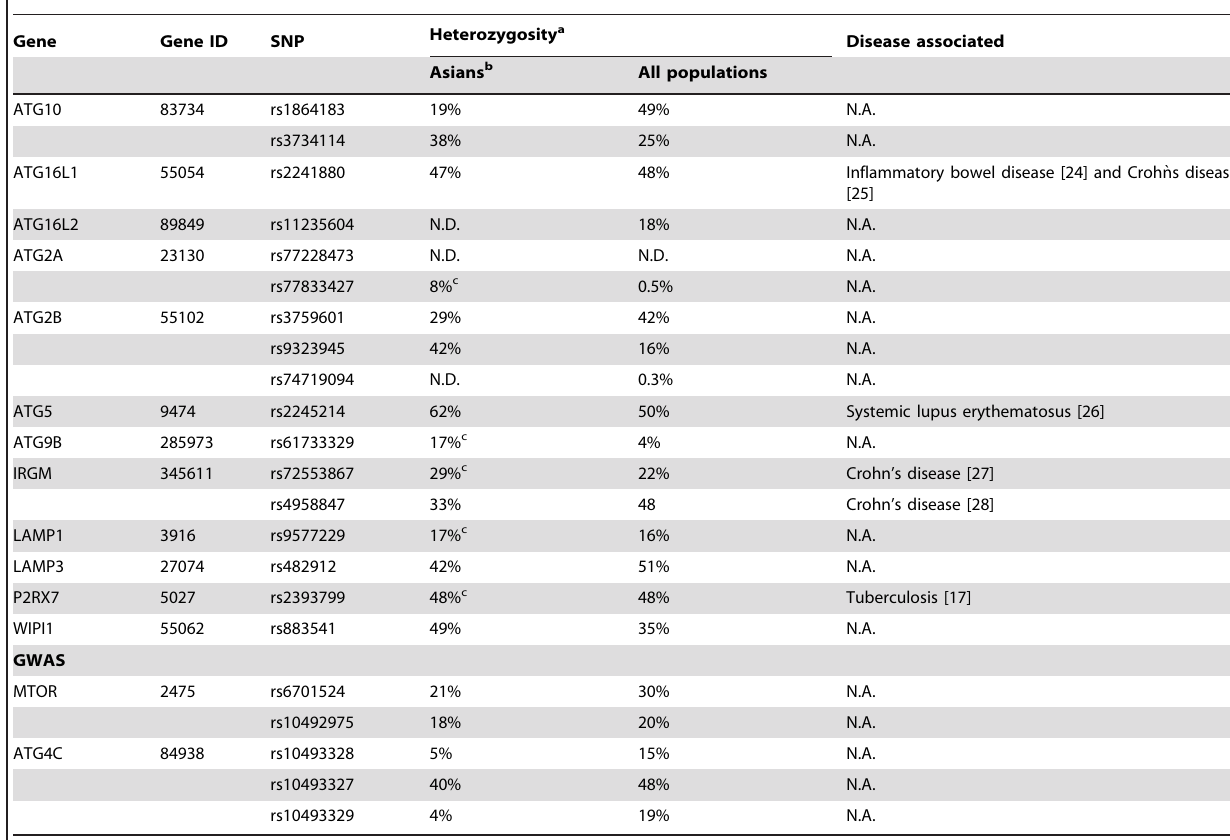
Table 1. Polymorphisms in autophagy genes studied.